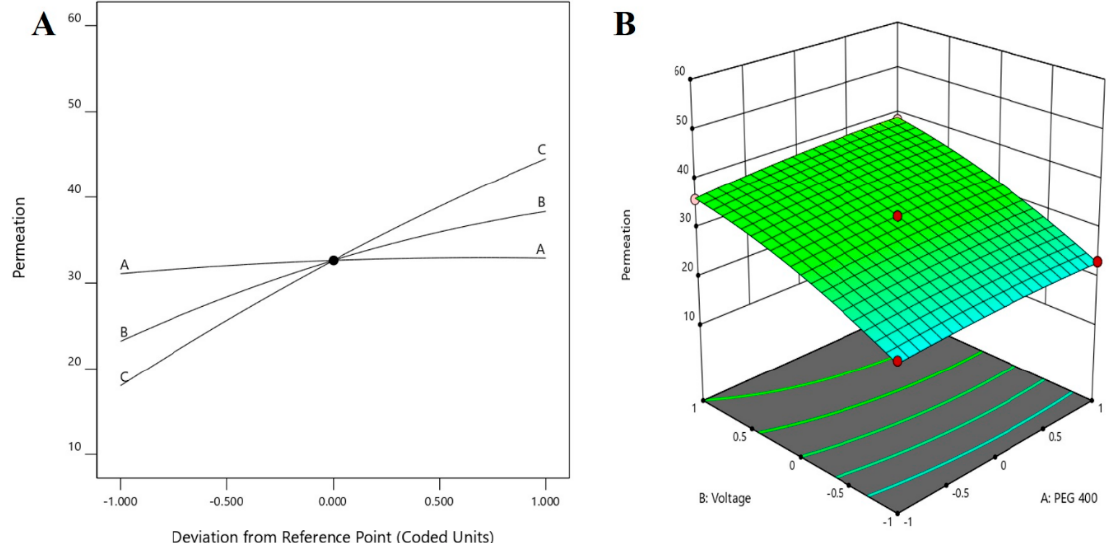
Figure 2. Effect of the independent variables on the permeation of drug ( A ) perturbation plot and ( B ) 3D surface plot.